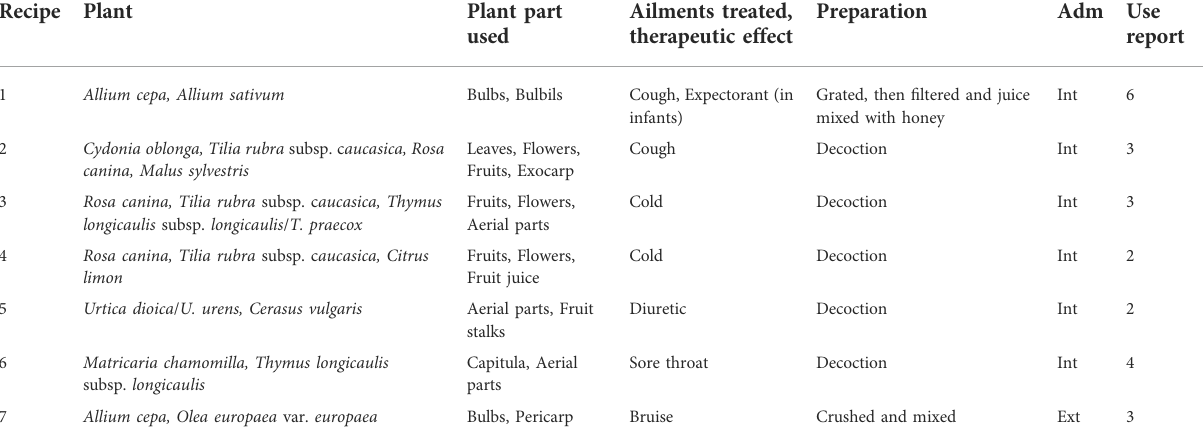
TABLE 4 Multiherbal recipes used as folk medicine in Ta ş köprü (Kastamonu/TURKEY). Recipe Plant